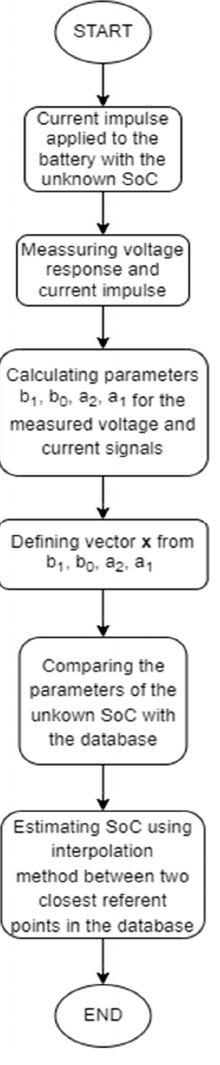
Figure 8. Flowchart for estimating unknown SoC.